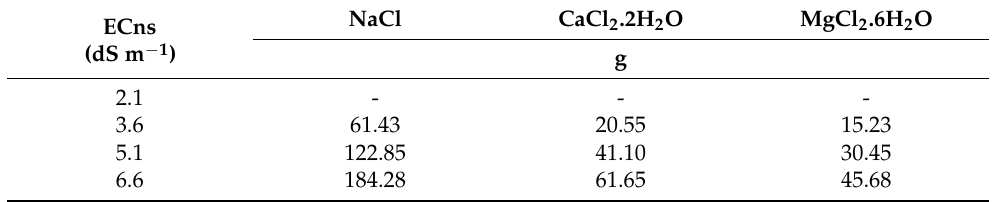
Table 1. Quantities of salts incorporated per 100 L of nutrient solution.